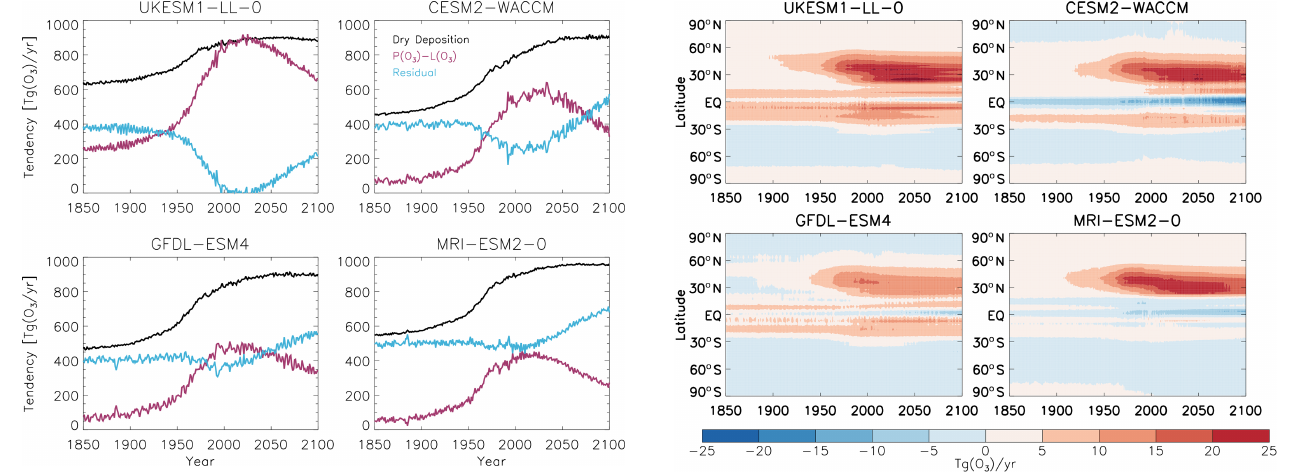
Figure 14. Integrated annual net chemical production of tro- pospheric ozone for UKESM1-0-LL, CESM2-WACCM, GFDL- ESM4 and MRI-ESM2-0. Results are historical (1850–2014) and ssp370 (2015–2100) simulations. Troposphere is masked by the tropopause pressure calculated in each model using the WMO ther- mal tropopause